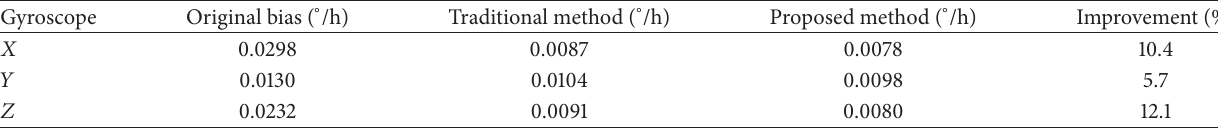
Table 1: The compensational results in gyroscope assembly.